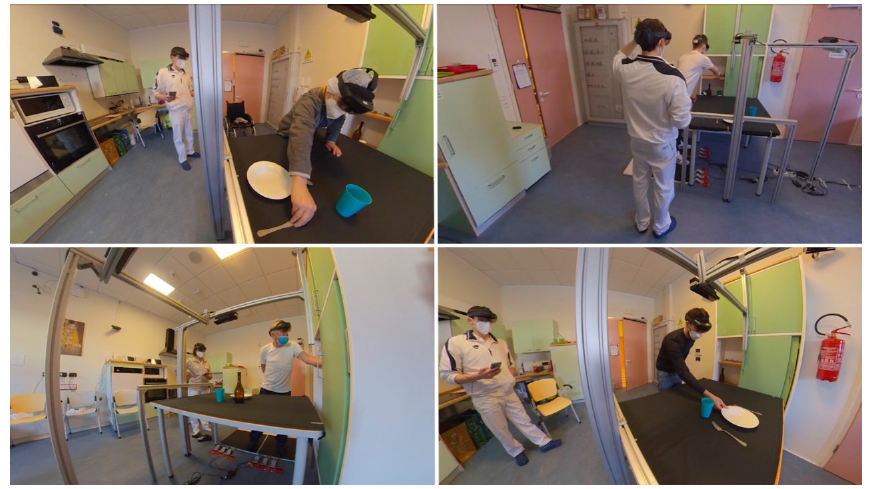
Figure 13. User study with four random testers among the eight